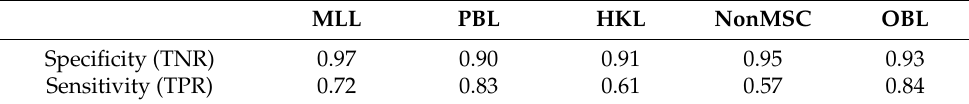
Table 2. Test values of sensitivity and specificity for MLL, PBL, HKL, NMSC, and OBL classification. Specificity and sensitivity values are given for a specific class vs. all